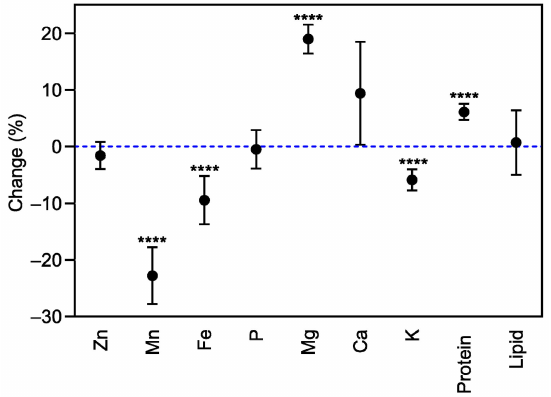
Figure 3. Mean response change (%) of the seed mineral, protein, and lipid concentrations of 18 bean